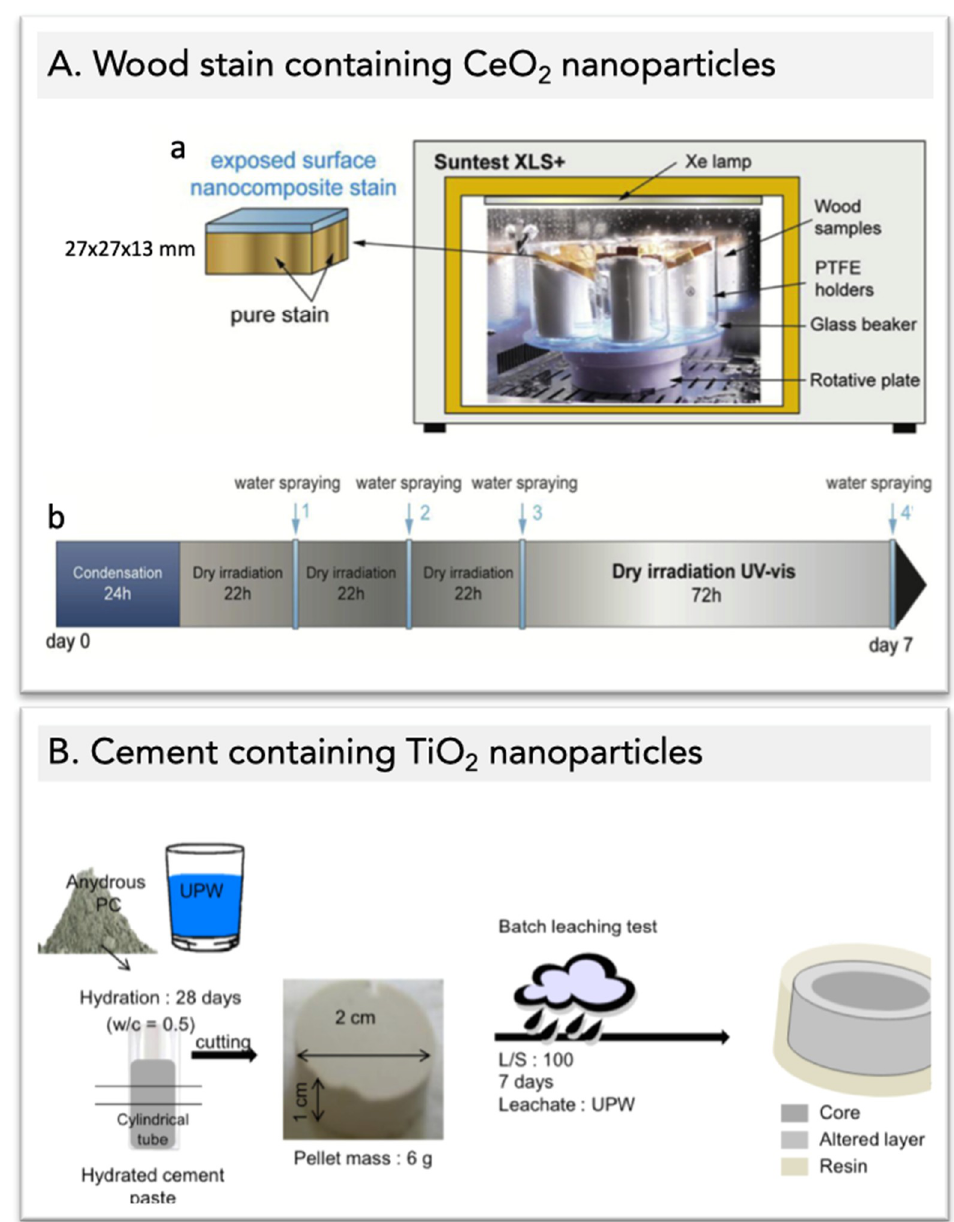
Figure 1. Experimental setup and procedure for the aging of two nano-enabled products with contrasting matrix (from [1,2]). ( A ) Experimental setup and procedure for weathering in climate chamber of wood stain containing CeO 2 nanoparticles. ( a ) Experimental setup inside the climate chamber (Suntest XLS+). ( b ) Weekly weathering cycle with gray areas corresponding to dry irradiation (UVvis) phases and 20 min spraying events (MilliQ-water) in light blue. ( B ) Experimental setup and procedure for the static leaching test of cement containing TiO 2 nanoparticles. Batch tests were performed during seven days at liquid-to-solid-weight ratio (L/S) of 100 with ultra-pure water.